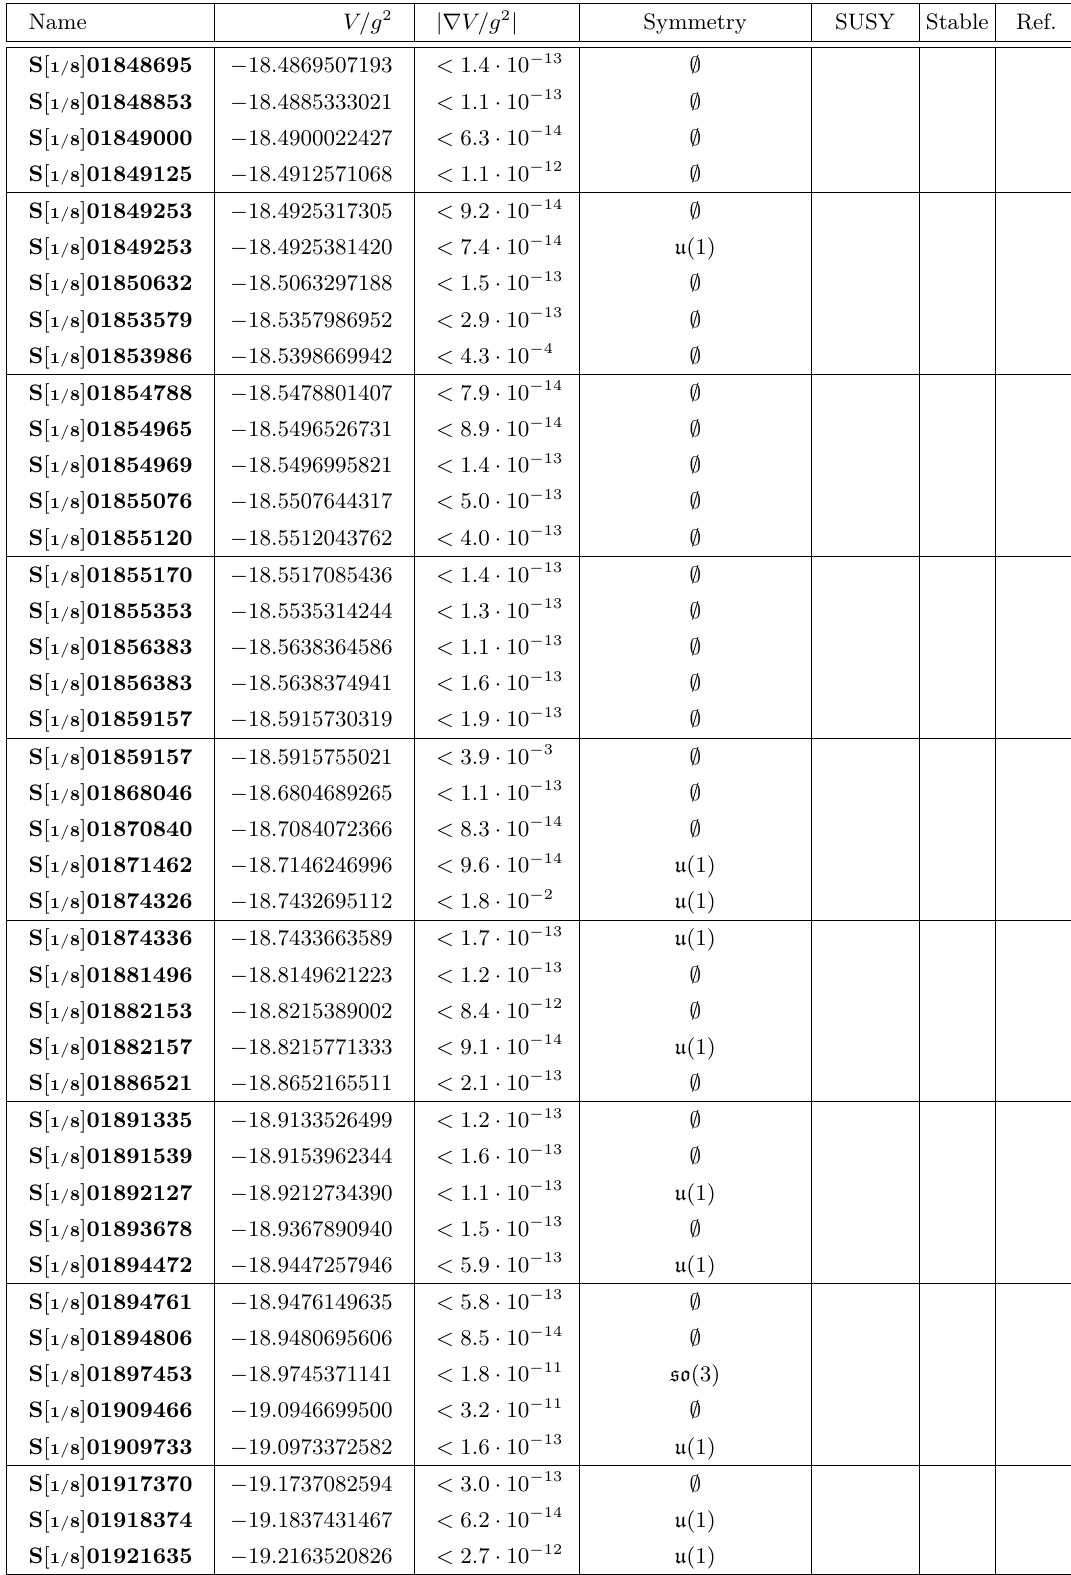
Table 1. Summary of vacua at ω = π/ 8